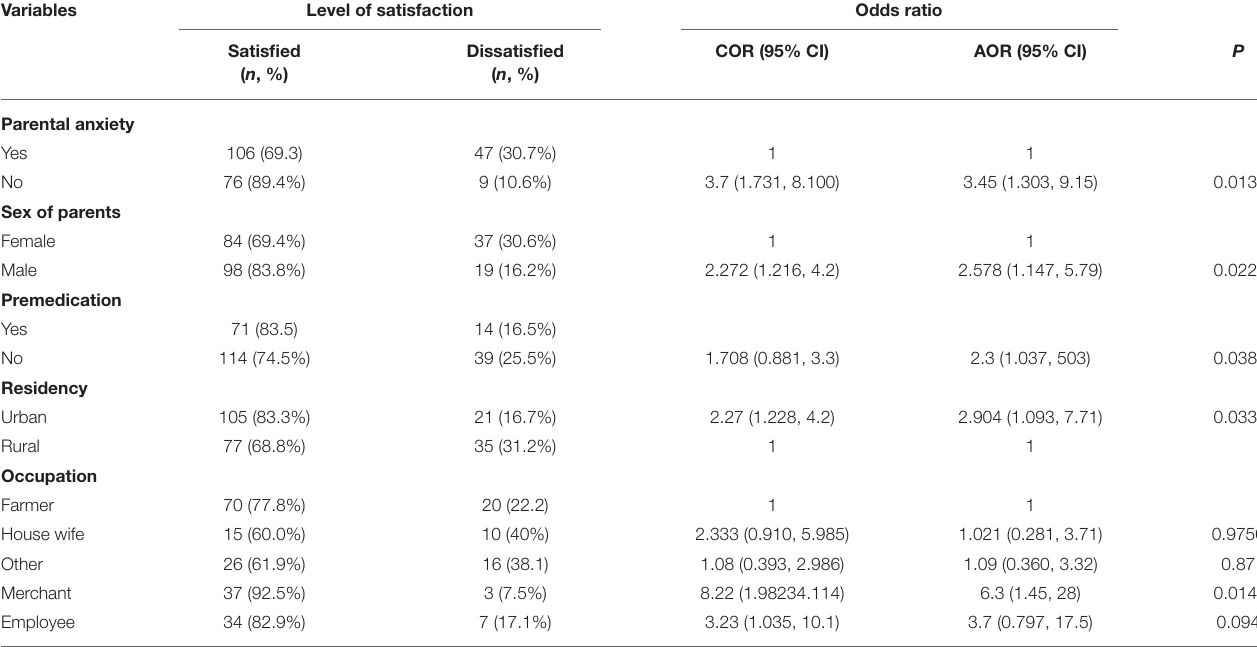
TABLE 5 | Multi-variable logistic regression analysis of factors associated with parental satisfaction toward their child’s anesthesia service, N = 238, 2021. Variables Level of